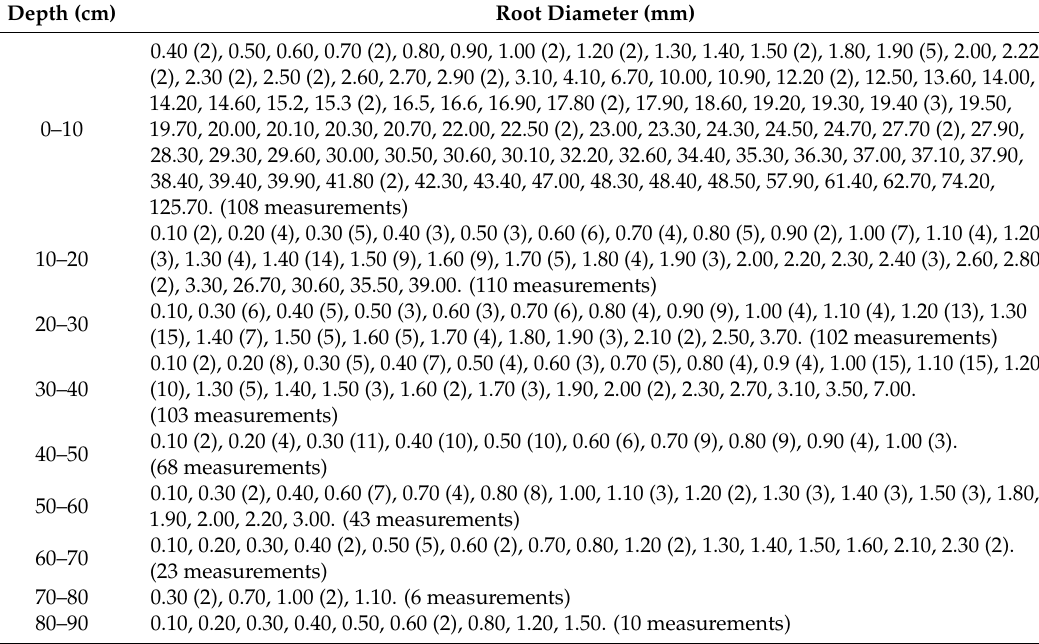
Table A5. Summary of all root diameters, in mm, measured for A. donax in depth increments of 10 cm from surface to 90 cm. Numbers in parenthesis show number of roots of that size.